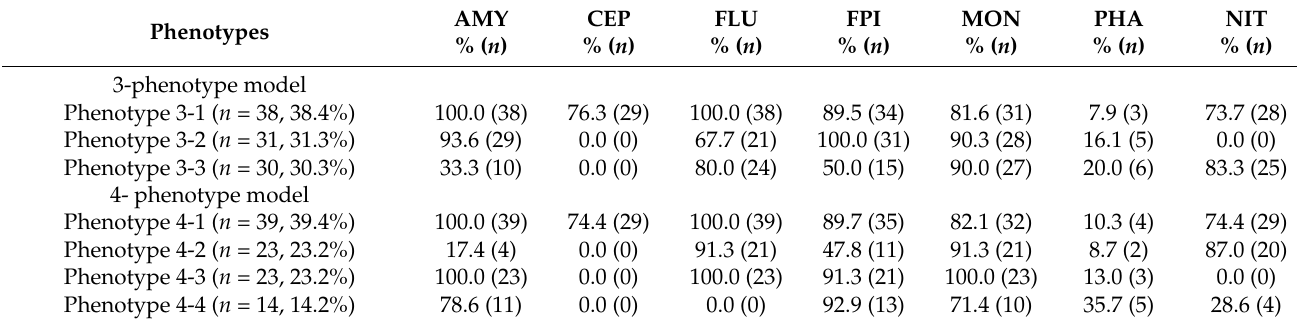
Table 5. Phenotypes and antibiotic resistance rate patterns of ESBL-producing uropathogenic E. coli according to the latent class analysis ( n =